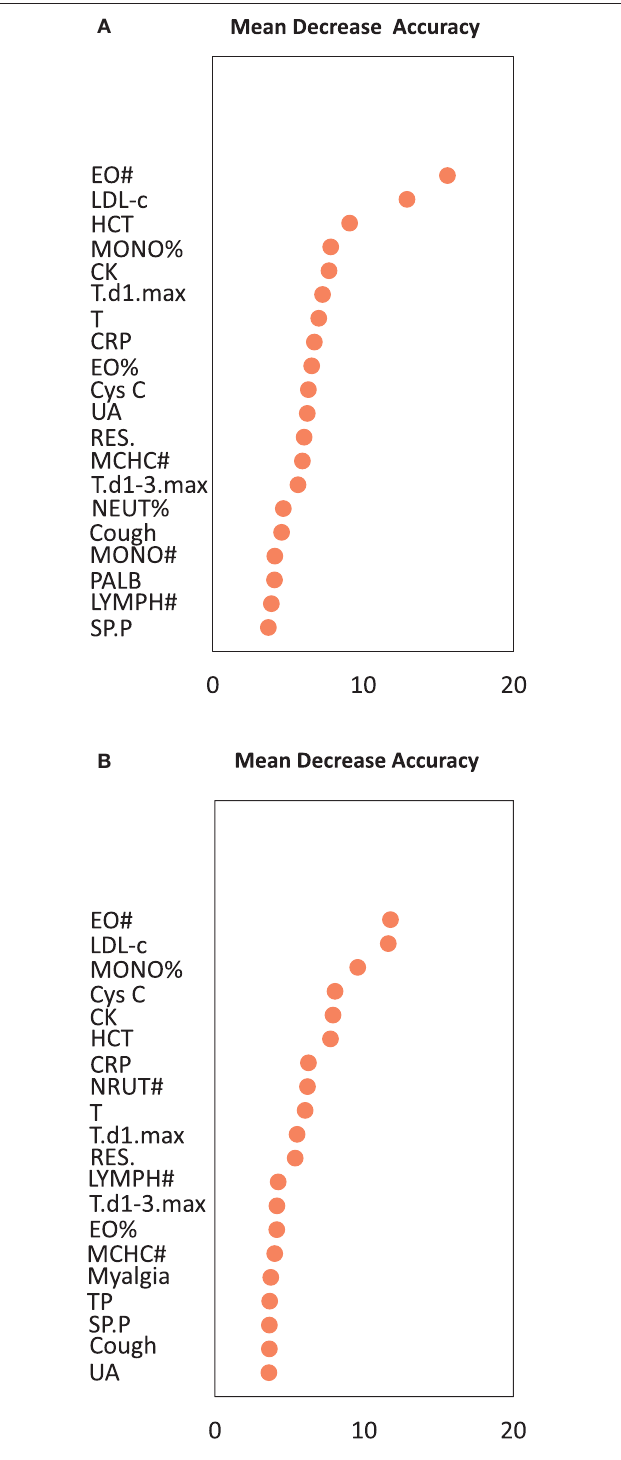
FIGURE 1 | The importance of variables in the random forest algorithm. (A) The importance of variables was calculated by all patients. (B) The importance of variables was calculated by training set. A multi-indicator model was constructed by combining 61 variables ( P < 0.05 in logistic regression analysis). Only Top 20 was shown.